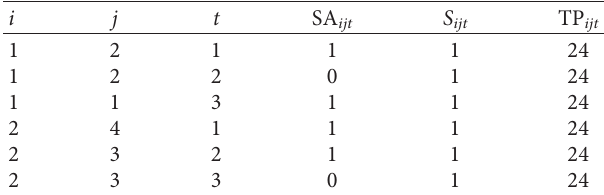
Table 7: Small dataset results of the base LSSP MILP: scheduling. i